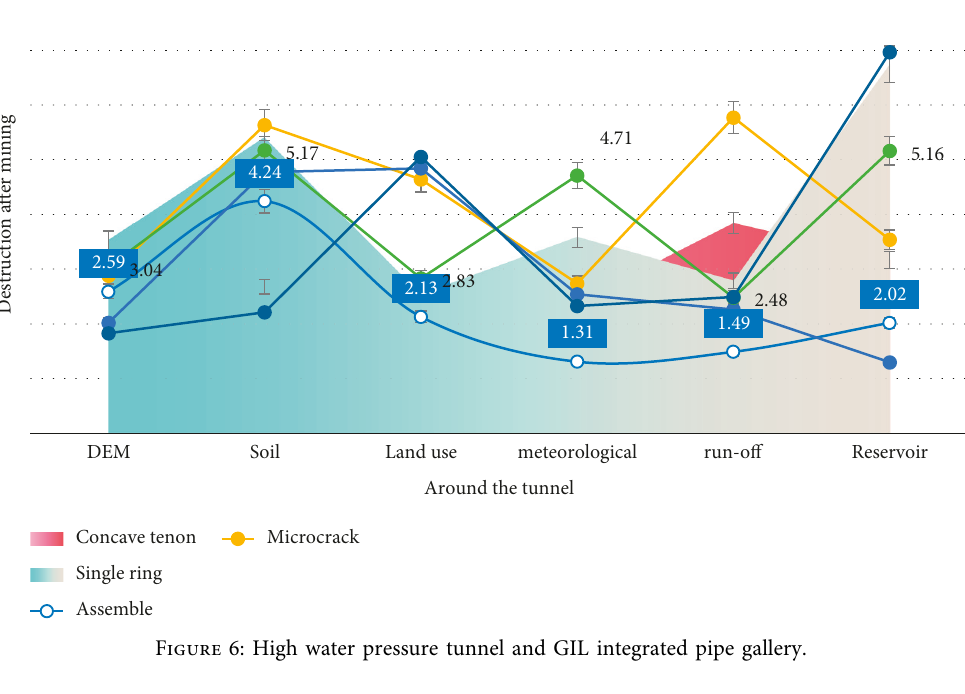
Figure 6: High water pressure tunnel and GIL integrated pipe gallery.